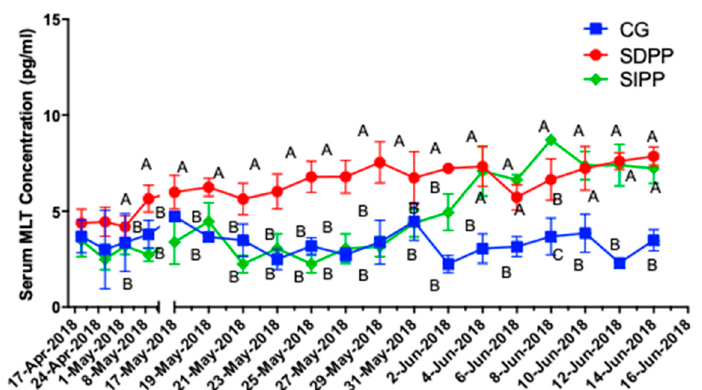
Figure 1. Effect of photoperiod change on MLT secretion. Different letters indicate significant difference at p < 0.05 among the groups. CG: control group; SDPP: short-day photoperiod; SIPP: shortening-day photoperiod.